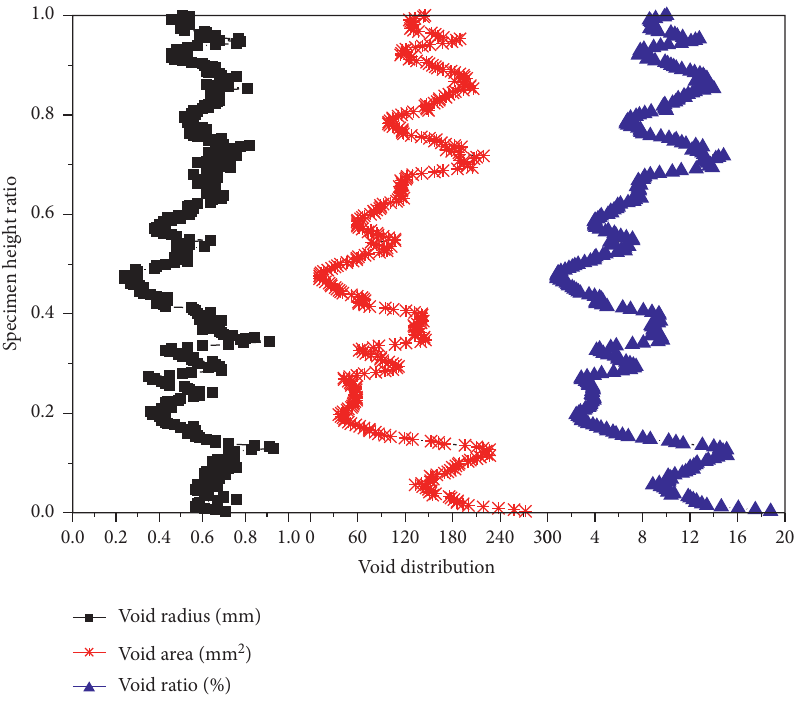
Figure 10: Air size distributions along with the SMA13 specimen height